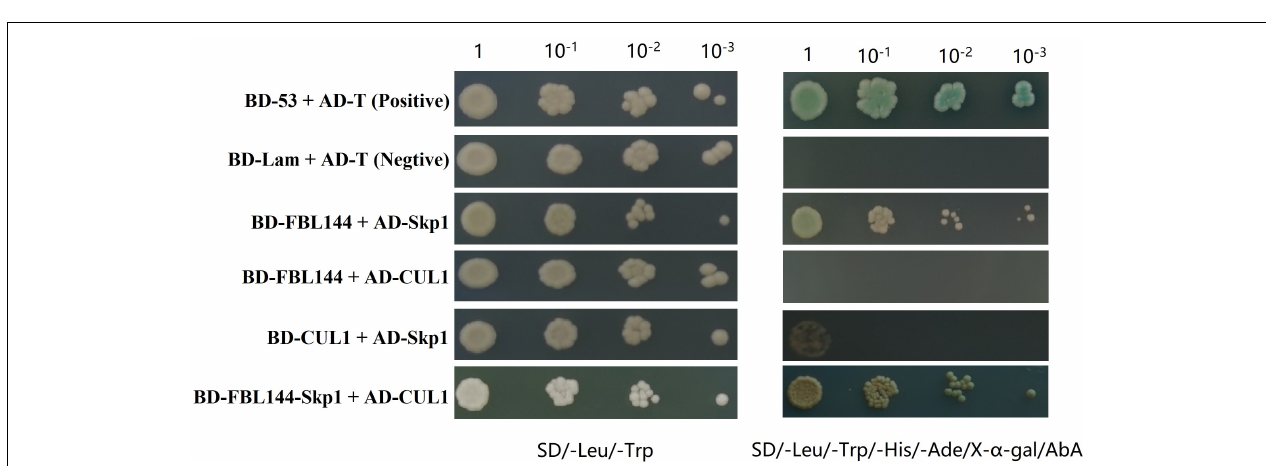
FIGURE 5 | Subcellular localization of GmFBL144 proteins. The fusion constructs and GFP driven by the 35S promoter were transiently expressed in tobacco leaves. Scale bars = 20 µ m.